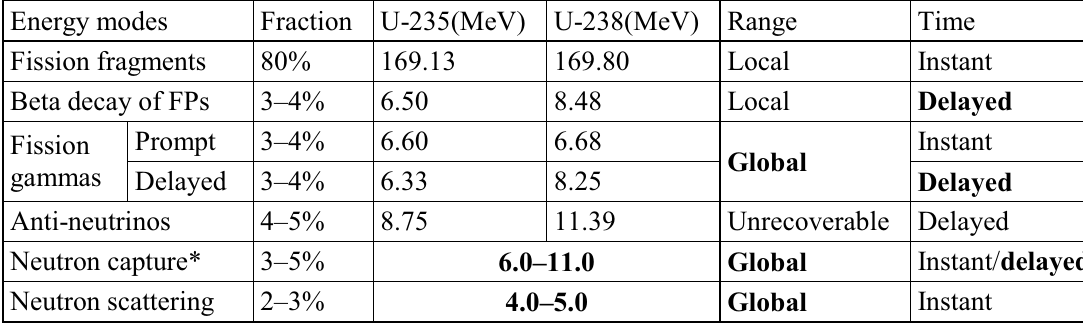
Table I. Fission energy release from